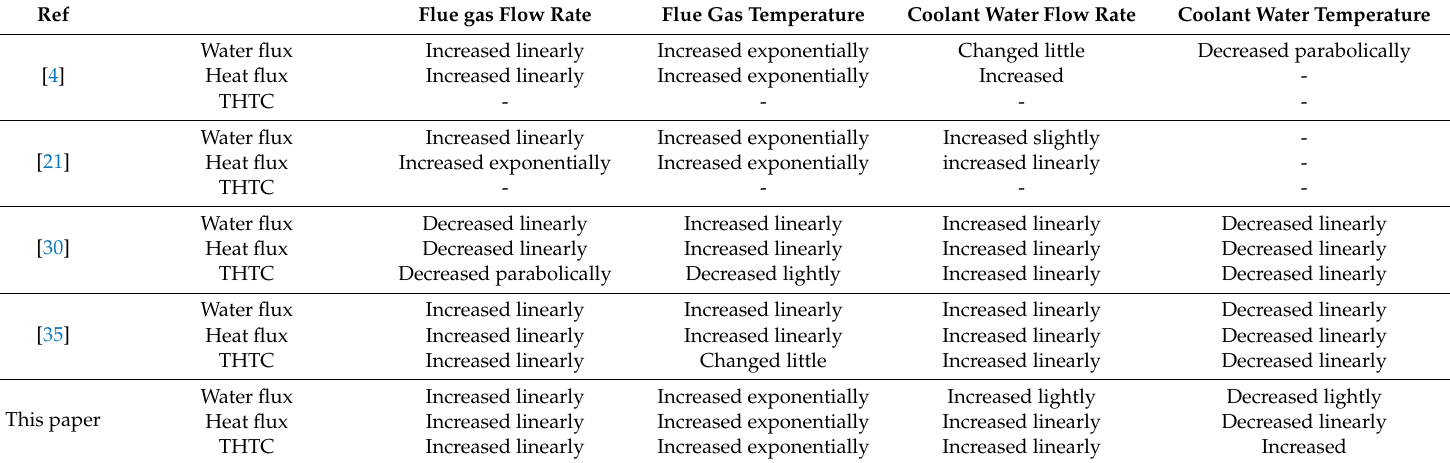
Table 4. Recovery performance variation with operational